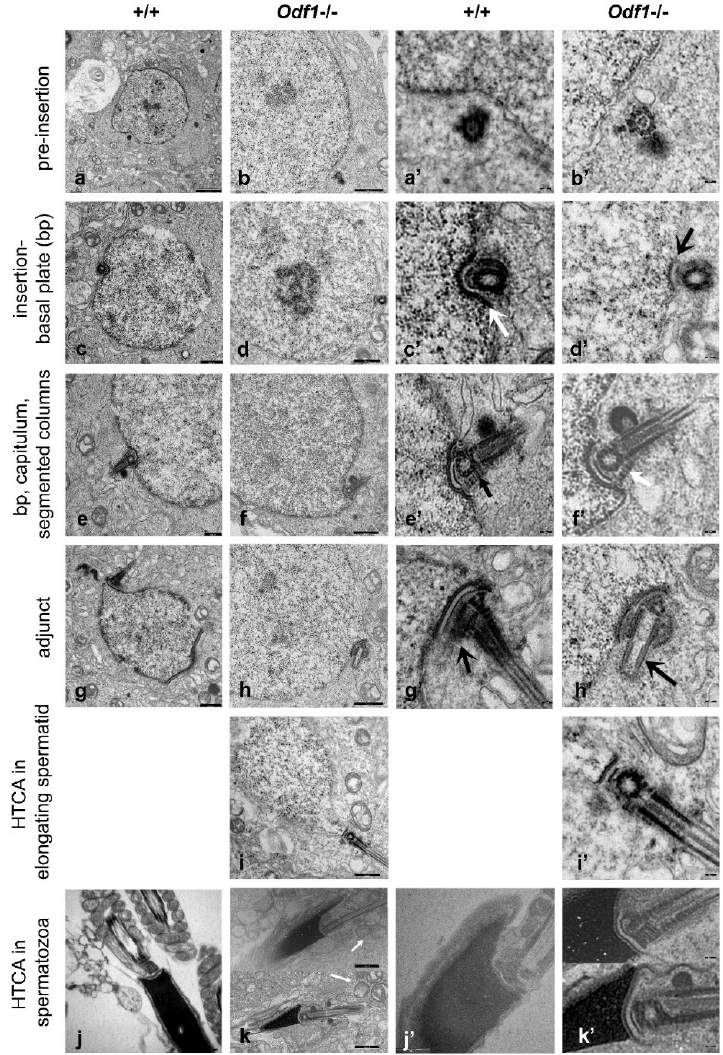
Figure 2. Transmission electron micrographs of the developing connecting piece in Odf1 -deficient ( − / − ) and wild-type spermatids (+/+). First sign of the development of the connecting piece before insertion into the implantation fossa ( a , b ) and respective enlargements ( a’ , b’ ). The proximal centriole is inserted into the implantation fossa and the basal plate (bp) develops ( c , d ) and respective enlargements ( c’ , d’ ; arrows indicate bp). Basal plate (bp), capitulum, and segmented columns are developed ( e , f ) and respective enlargements ( e’ , f’ ; arrows indicate segmented columns). The adjunct is visible ( g , h ) and enlargements ( g’ , h’ ; the adjunct is indicated by arrows). The head-to-tail coupling apparatus (HTCA) in elongating spermatids in the absence of ODF1 ( i , i’ ). Fully developed HTCA in elongated Odf1 -deficient spermatozoa in the testis ( k ) and enlargement ( k’ ); the arrows in k indicate the disorganised mitochondria, and in epididymal Odf1 +/+ spermatozoa ( j , j’ ). ( j ) Odf1 +/+ spermatozoa of 129Sv background, ( j’ ) Odf1 +/+ - but Spag4 − / − -deficient spermatozoa ( j’ ). Scale bars: 2500 nm ( a ), 1000 nm ( b – d , f – i , k,a’ – i’ , k’ ), 500 nm ( e , j’ ), 100 nm ( j ). ( g , g’ , j ) Reprinted by permission from Springer Nature (license number 5358120337911): Springer Nature, Histochemistry and Cell Biology, Ultra- structure of the sperm head-to-tail linkage complex in the absence of the spermatid-specific LINC component SPAG4, Yang et al., 2018 [17].